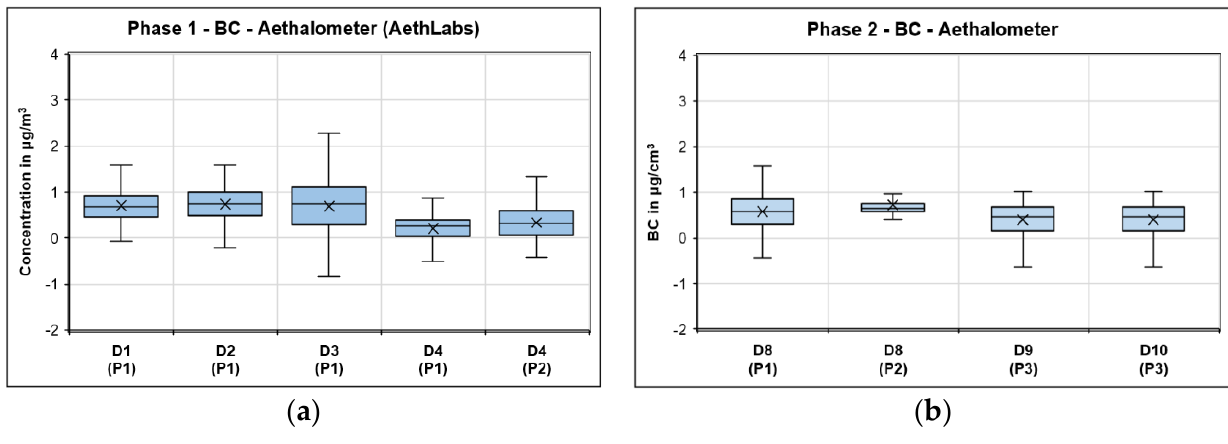
Figure 20. BC measurements during ( a ) phase 1 and ( b ) phase 2 measurements.